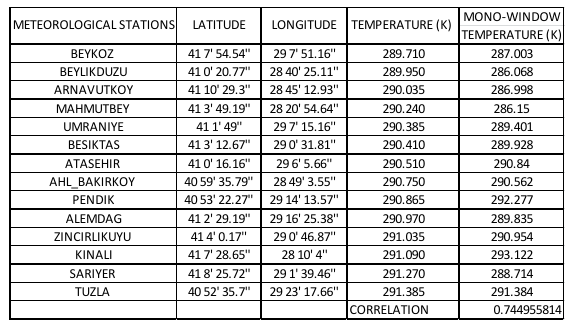
Table 9. Correlation between LST Temperature and Meteorological Stations Temperature